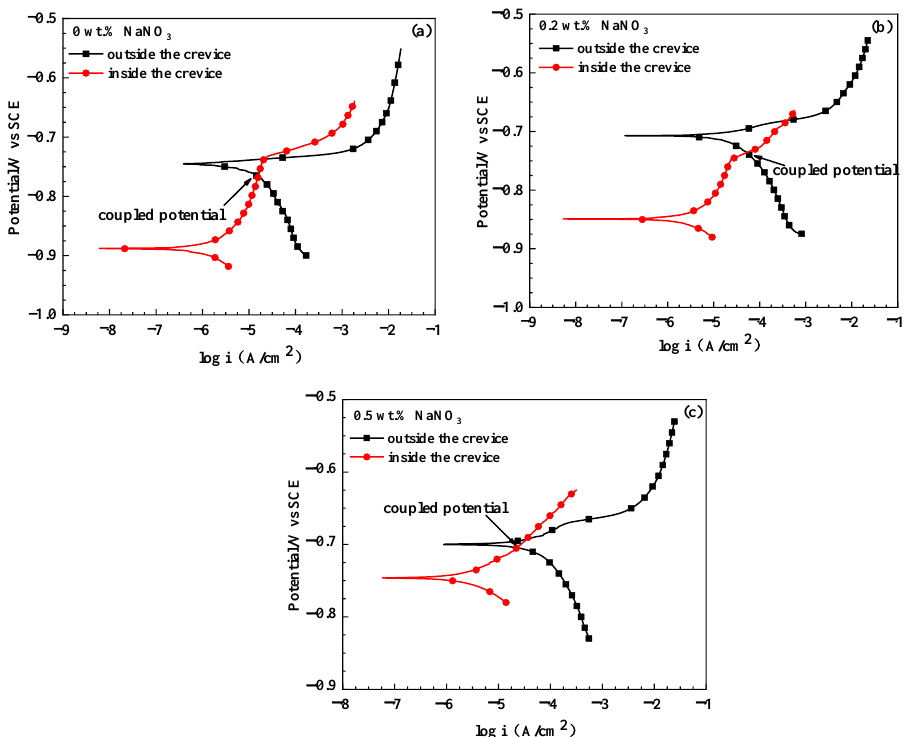
Figure 4. The polarization curves of specimens inside and outside the crevice in solutions with different concentrations of NaNO 3 after corrosion for 24 h. ( a ) 0 wt.% NaNO 3 , ( b ) 0.2 wt.% NaNO 3 , ( c ) 0.5 wt.% NaNO 3 .